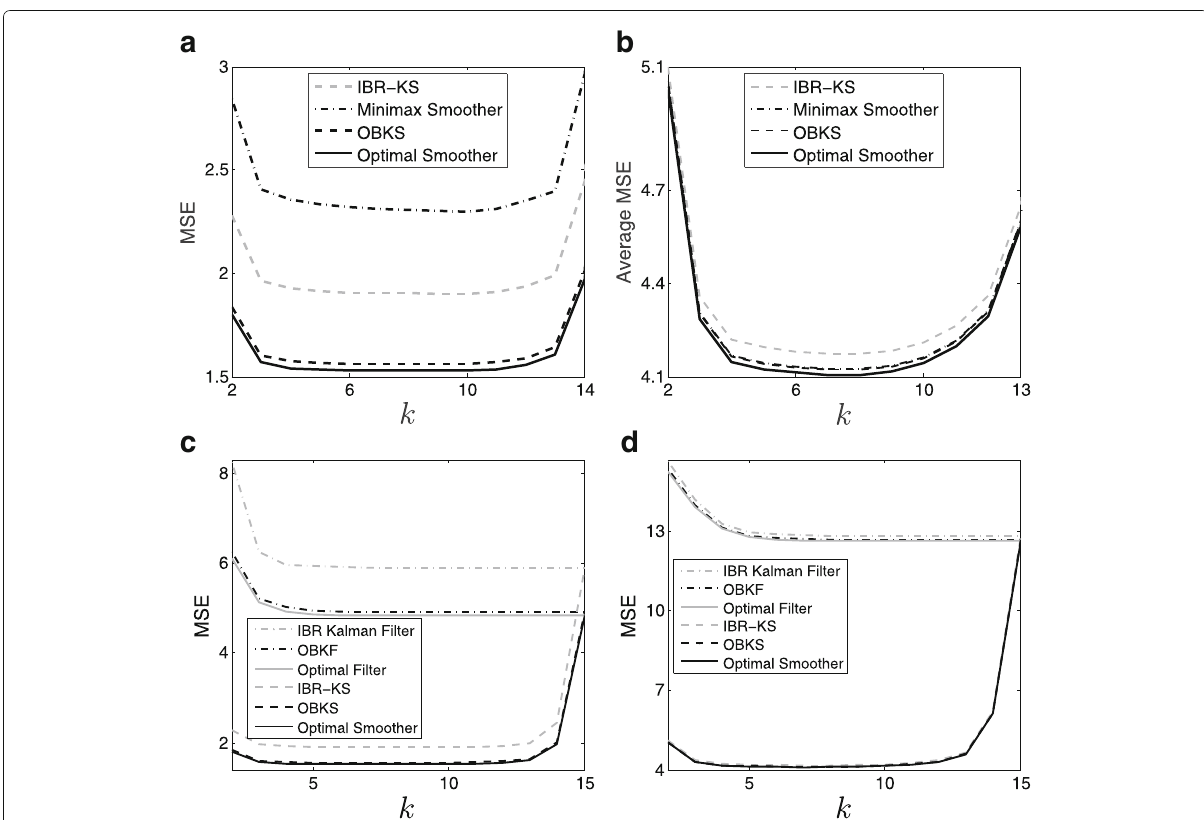
Fig. 3 Performance analysis of different smoothers for the target tracking example over the observation window. a MSE of different smoothers for θ = 0.5. b MSE of different smoothers for θ = 4. c MSE of different smoothers and filters for θ = 0.5. d MSE of different smoothers and filters for θ = 4